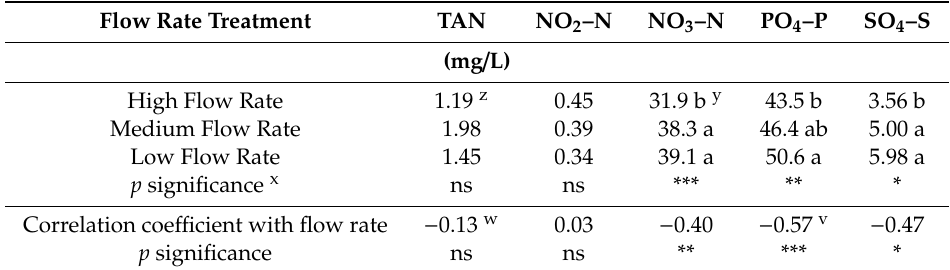
Table 3. Average concentrations of total ammonia nitrogen (TAN), nitrite (NO 2 –N), nitrate (NO 3 –N), phosphate (PO 4 –P), and sulfate (SO 4 –S) in aquaponic solution as affected by high (HFR, 3.3 m/day), medium (MFR, 2.2 m/day), and low (LFR, 1.1 m/day) flow rate. Water samples for analyses were collected from fish tanks.